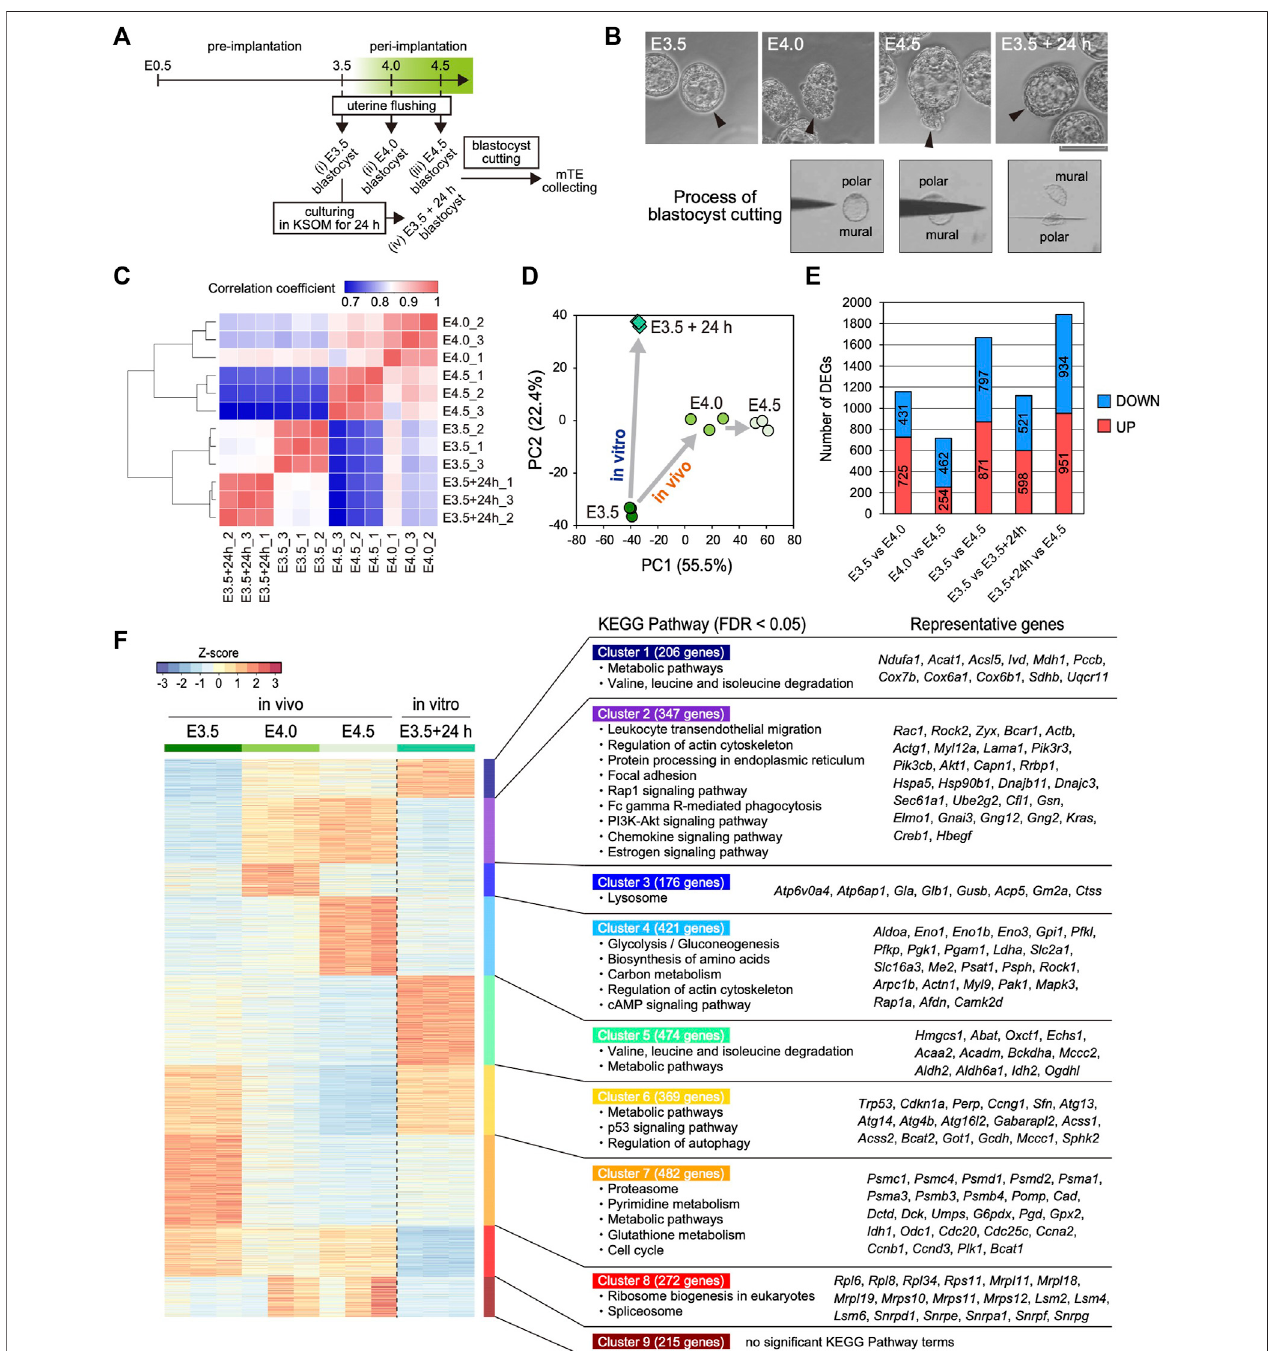
FIGURE1| Transcriptomic pro fi lingofthemTEatE3.5,E4.0andE4.5 (A) Schemesfortheproductionof Egfp -OEand Cdx2 -OE blastocysts, and theassessment of implantation ability in vitro and in vivo (B) Images of the prepared blastocysts (top) and successive images of the mTE isolation by amicroblade (bottom). Arrowheads indicatethetipsofthemTE.Scalebar:100 µm (C) HeatmapshowingSpearman ’ scorrelationofRNA-seqreplicates (D) Principalcomponentanalysis(PCA)oftheE3.5, E4.0, E4.5 and E3.5 + 24 h mTE (E) The number of DEGs between each stage of the mTE (F) Heatmap of k-means non-hierarchical clustering and the KEGG Pathway with signi fi cant enrichment of genes included in each cluster.